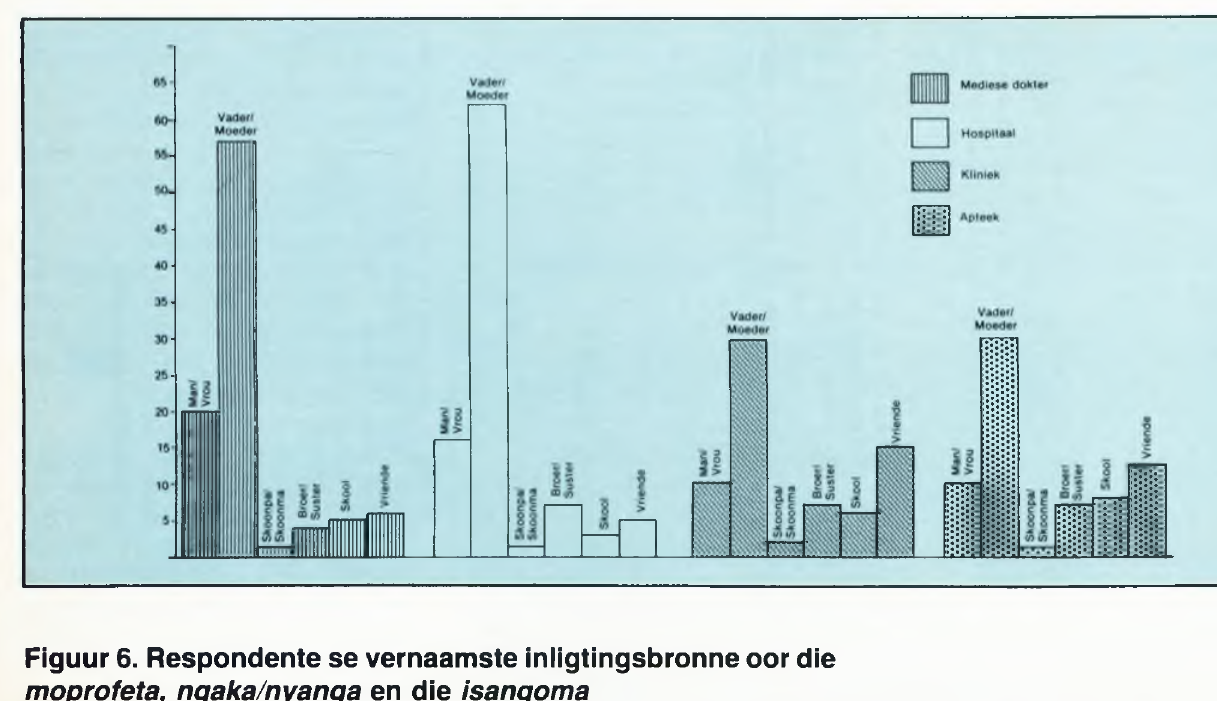
Figuur 6. Respondente se vernaamste inligtingsbronne oor die moprofeta, ngaka/nyanga en die